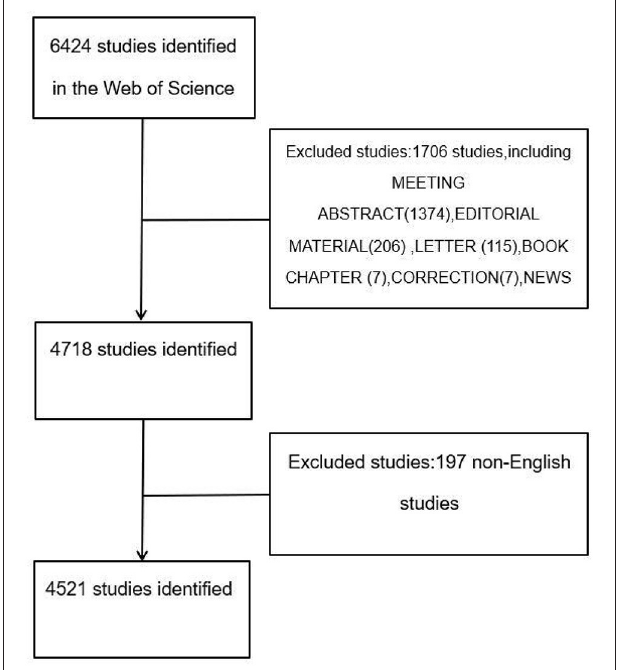
FIGURE 1 | Flowchart of literature